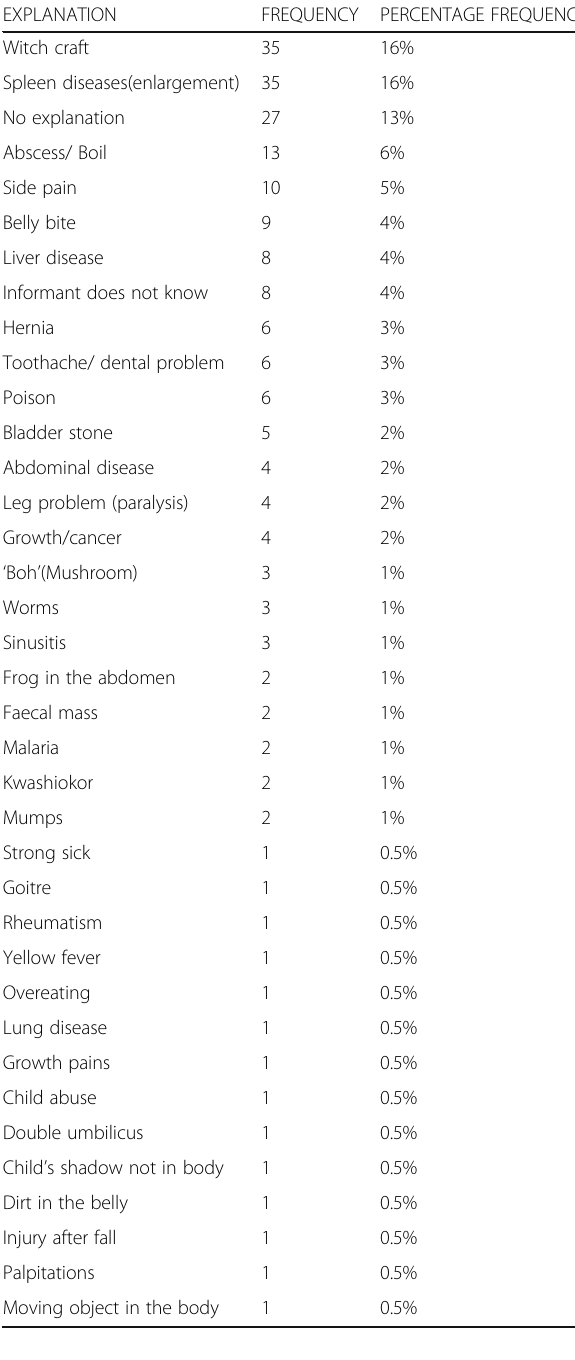
Table 2 The various explanations for Burkitt ’ s lymphoma